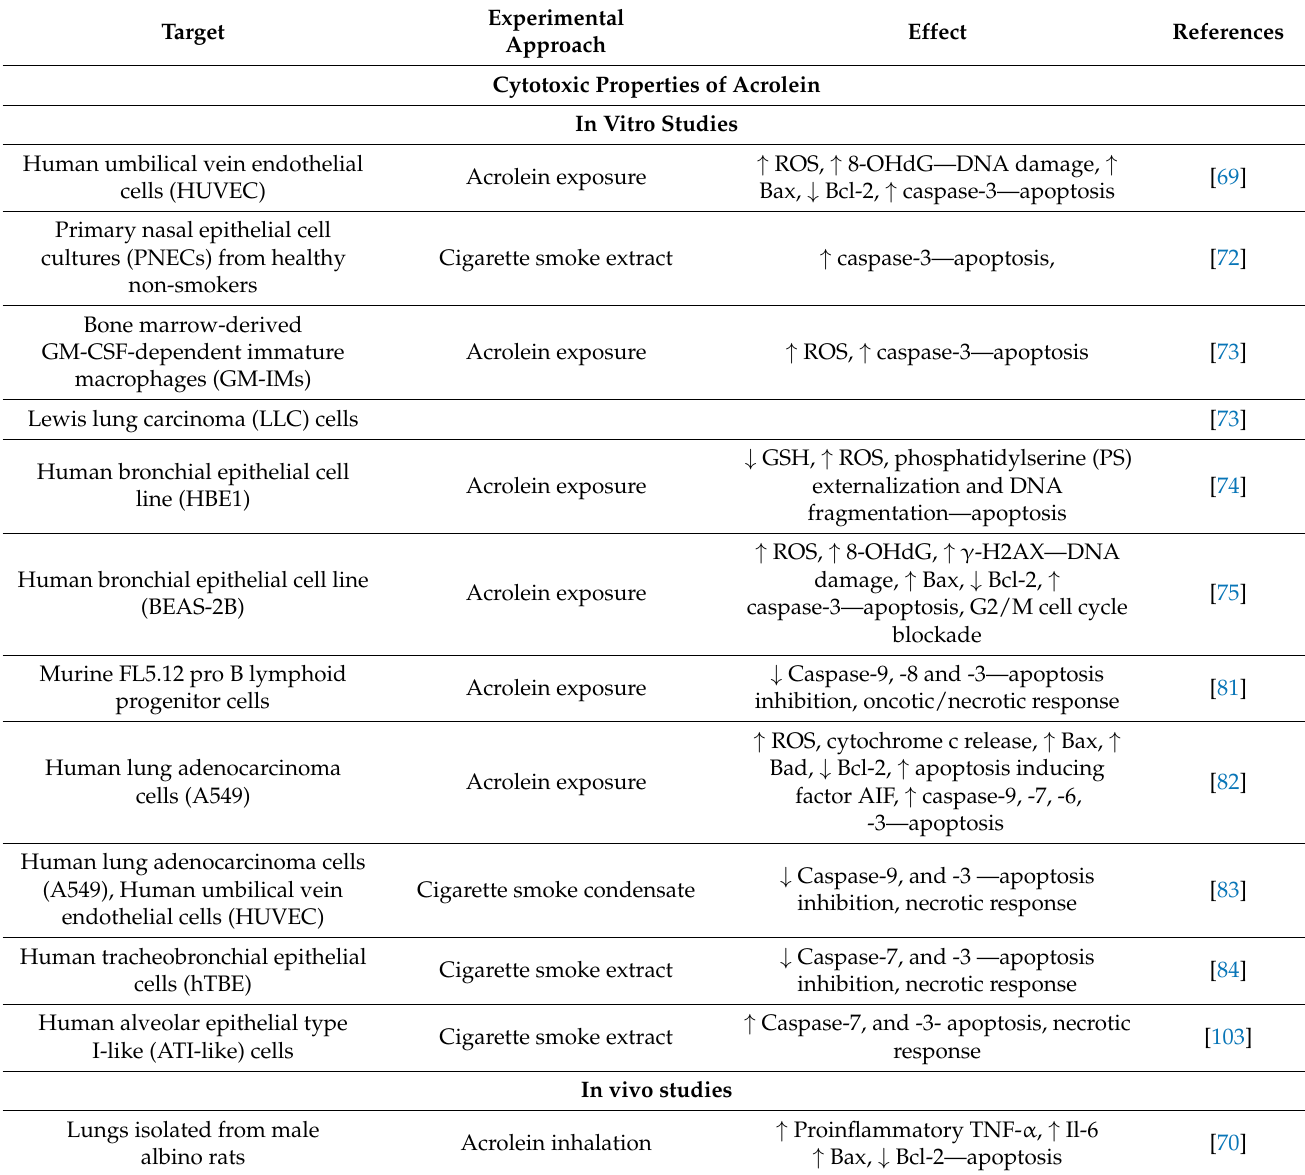
Table 1. Cellular and molecular targets of acrolein related to its molecular mechanisms of activity in chronic lung diseases and respiratory